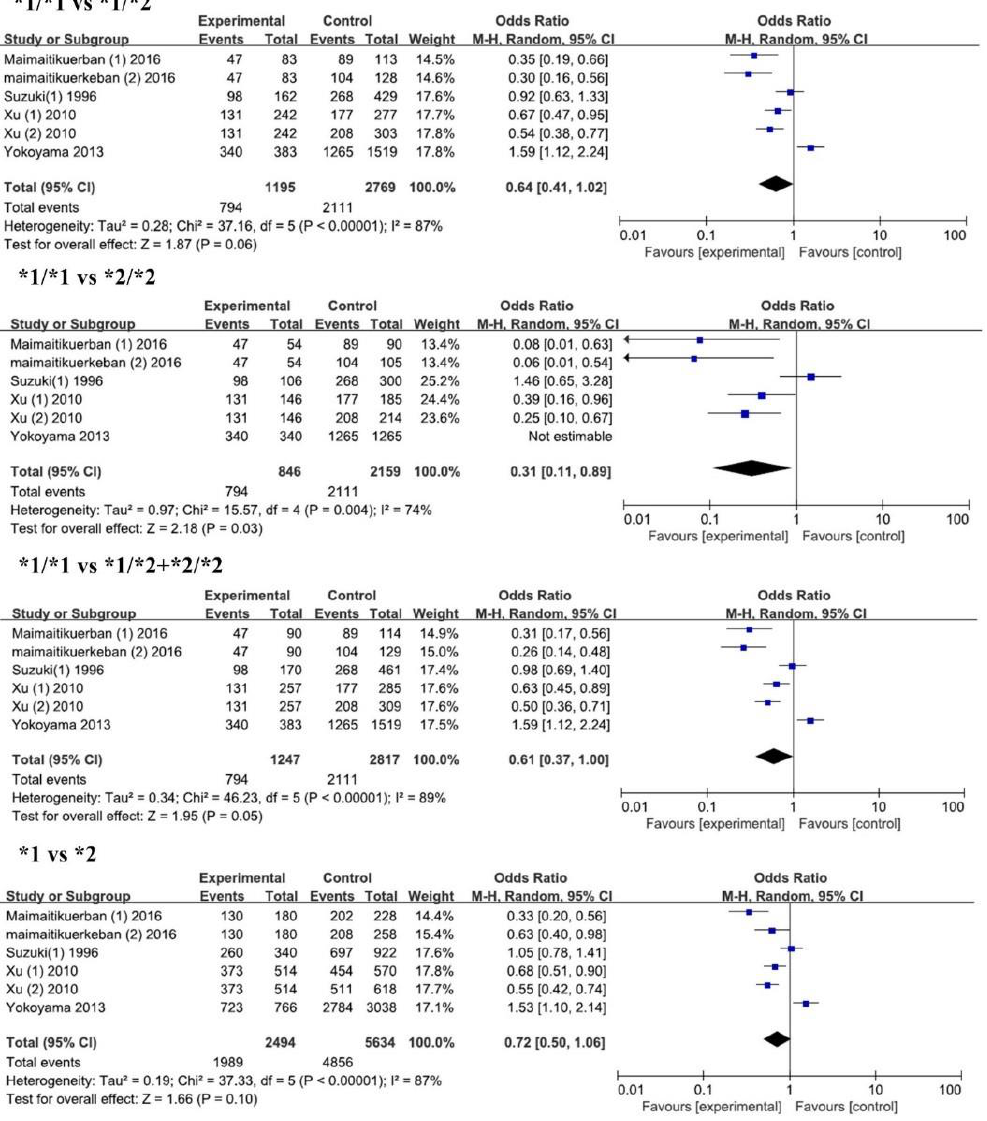
Figure 2. Forest plots of odds ratio for the association between ALDH2 rs671 and risks of T2DM.